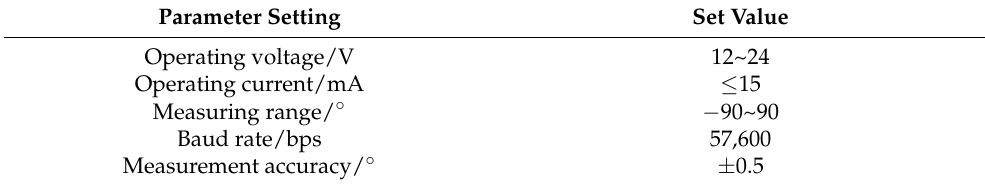
Table 4. Inclination sensor parameters.